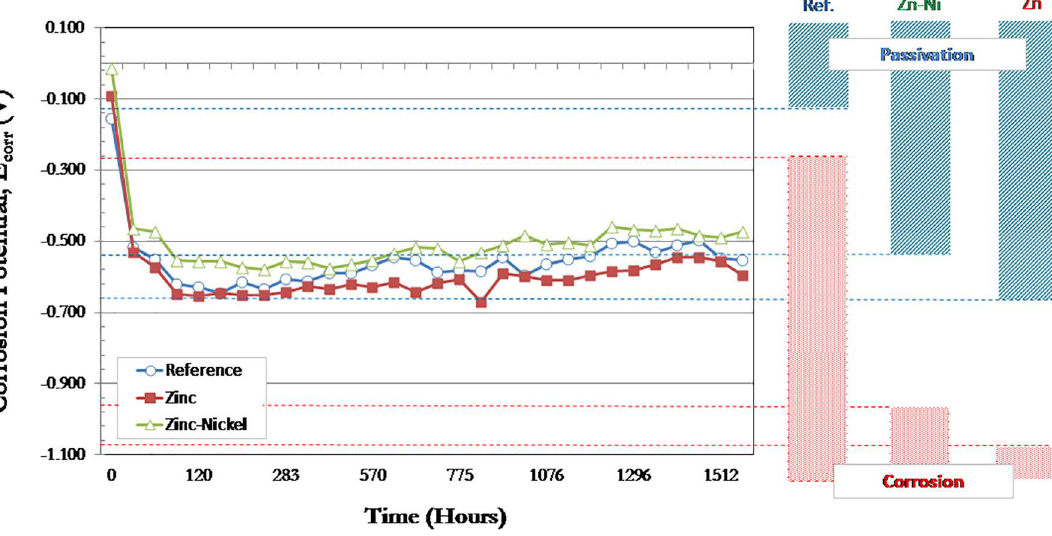
Figure 7. Evolution of the corrosion potential of reference and coated rebars exposed to salt